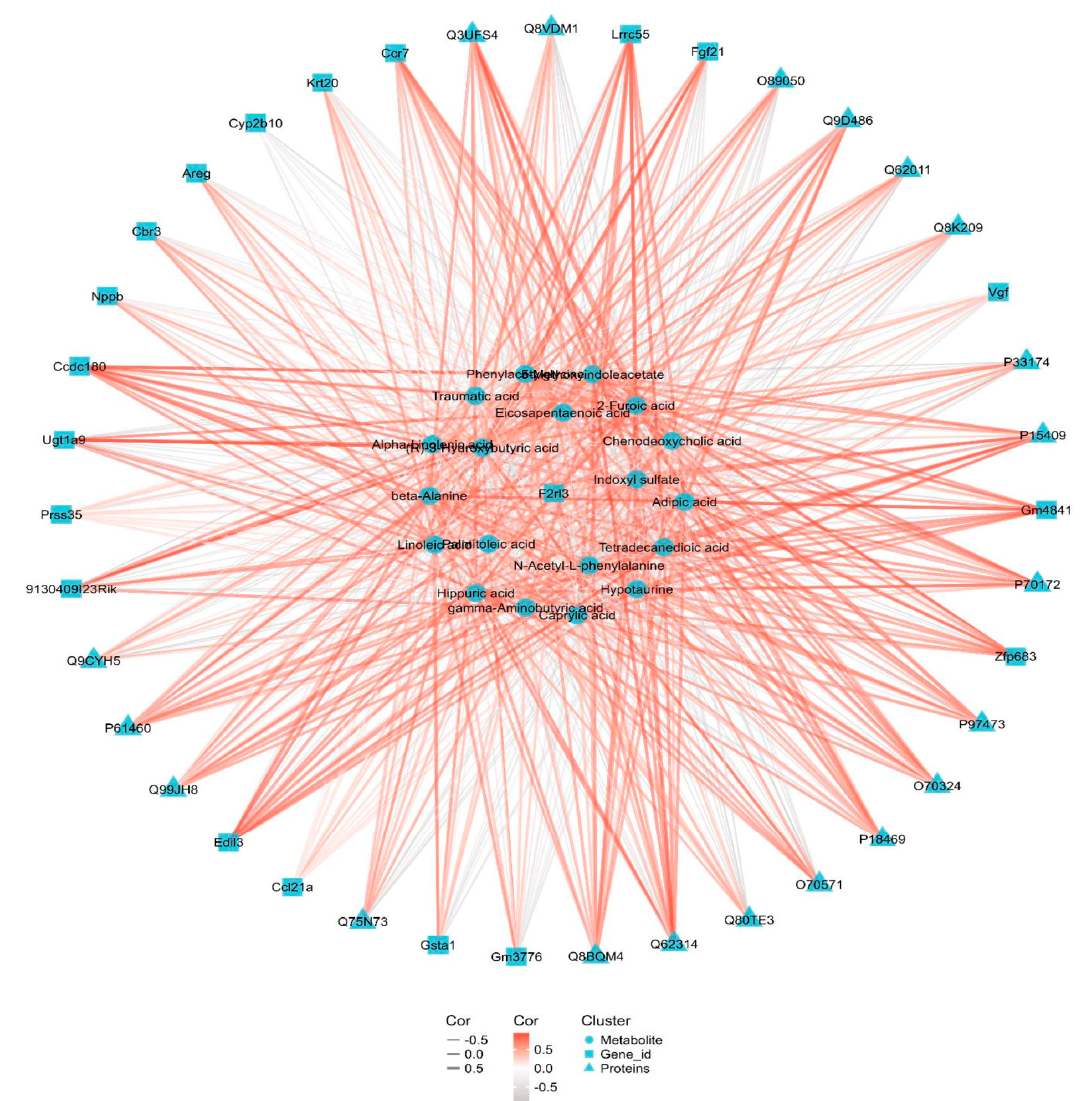
Figure 6. Integrative network of transcriptome, proteome and metabolome datasets.